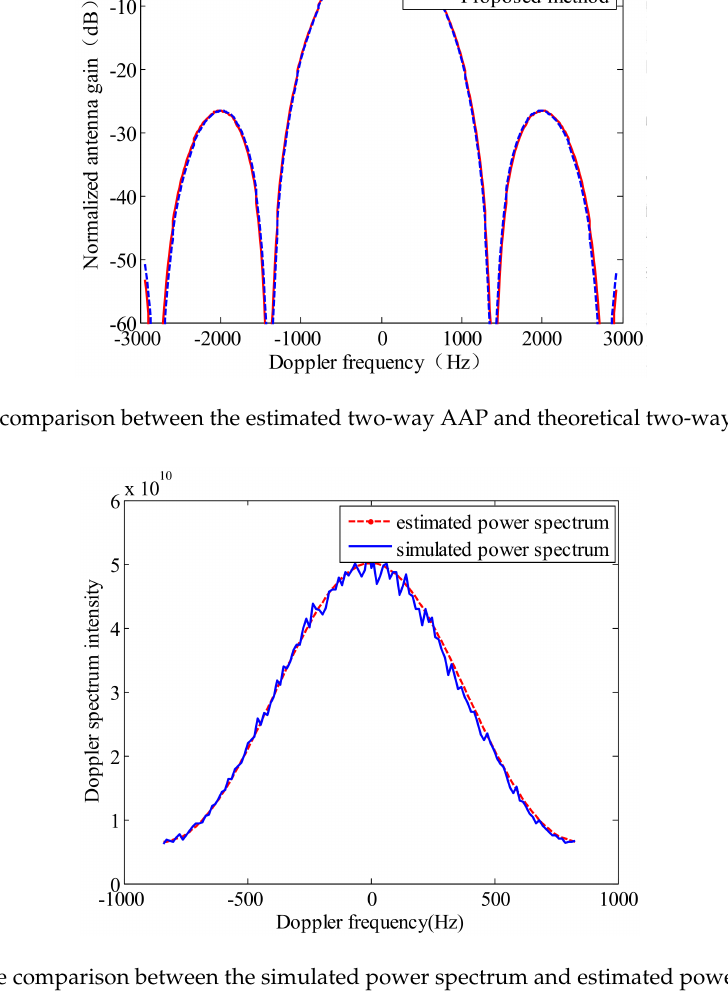
Figure 5. The comparison between the simulated power spectrum and estimated power spectrum.